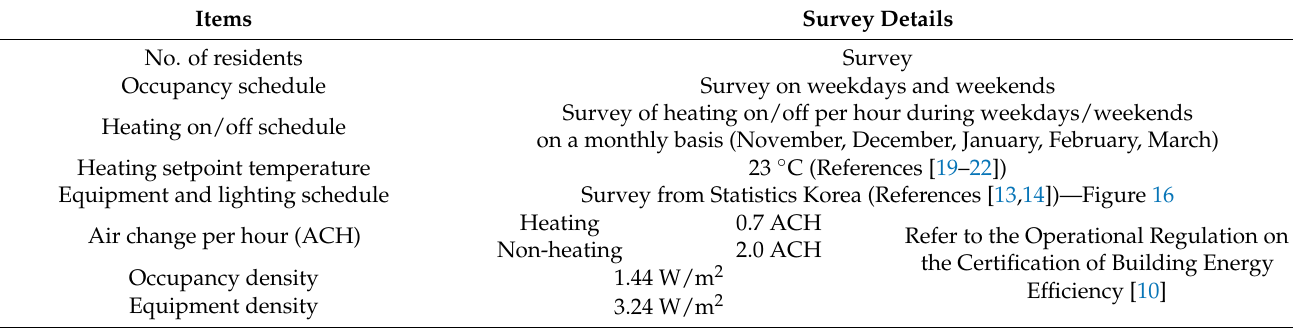
Table 9. Survey details and simulation